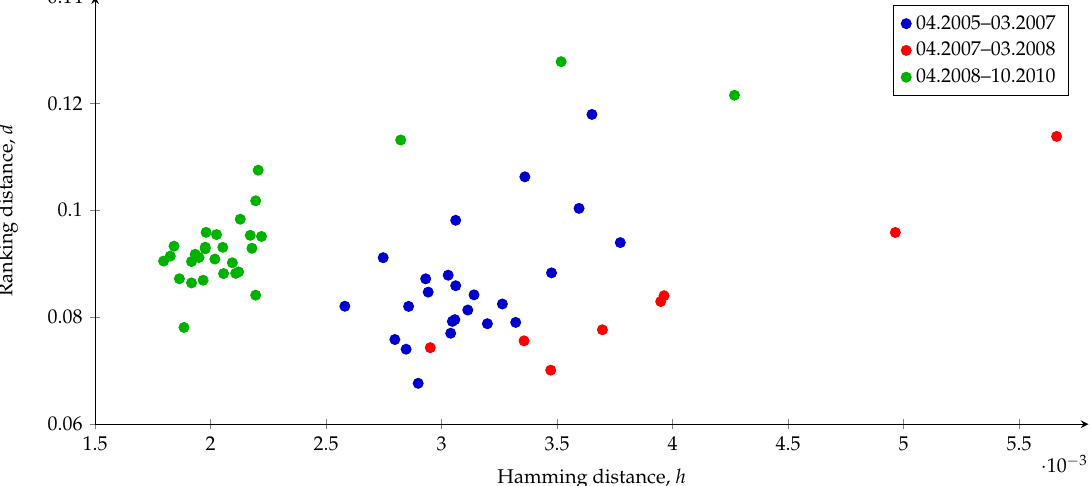
Figure 4. The evolution of the ranking and the Hamming distances between each pair of company co-mention networks constructed for each pair of consecutive six-month periods, i.e., 1–2, 2–3, ...,